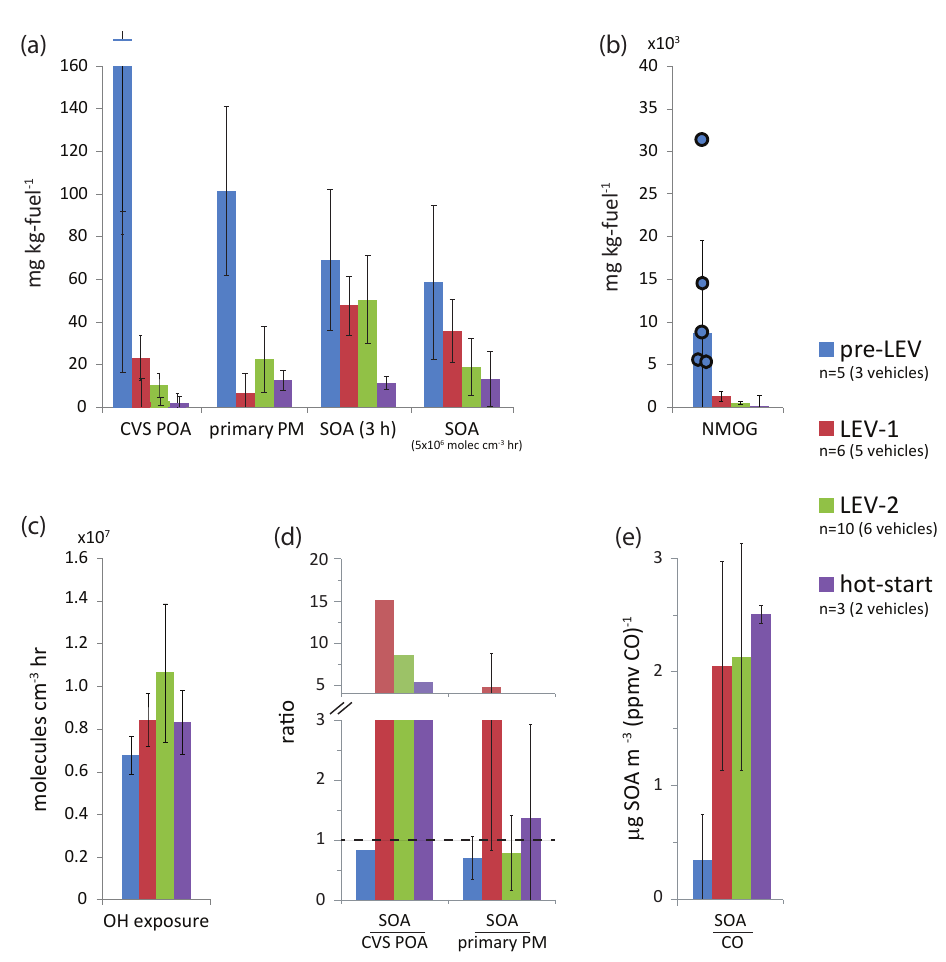
Fig. 6. Primary emissions and chamber data for hot- and cold-start UC chamber experiments with vehicles from the three LEV classes. (a) Median POA, primary PM (primary PM was not measured for LEV2-3.1), and (b) NMOG emissions measured in the CVS (filled circles represent individual measurements). Median SOA production (a) during 21 cold-start UC chamber experiments after 3h of photooxidation (“SOA (3h)”) and after 5 × 10 6 moleculescm − 3 h of OH exposure (LEV1-2.1 and high-emitter (LEV1-6) outliers were removed). (c) Median OH exposures after 3h of photooxidation. (d) Median ratios of SOA to primary PM and SOA to POA after 5 × 10 6 moleculescm − 3 h of OH exposure. The dashed horizontal line in (d) represents 1:1. (e) Median ratios of SOA (5 × 10 6 moleculescm − 3 h of OH exposure) to CO. Error bars represent uncertainty/variability propagated through all measured variables. Only one experiment is shown (no error bar) for the hot-start SOA-to-POA ratio. Error bars for other SOA-to-POA ratios are not included; they are large due to several experiments with extremely low POA